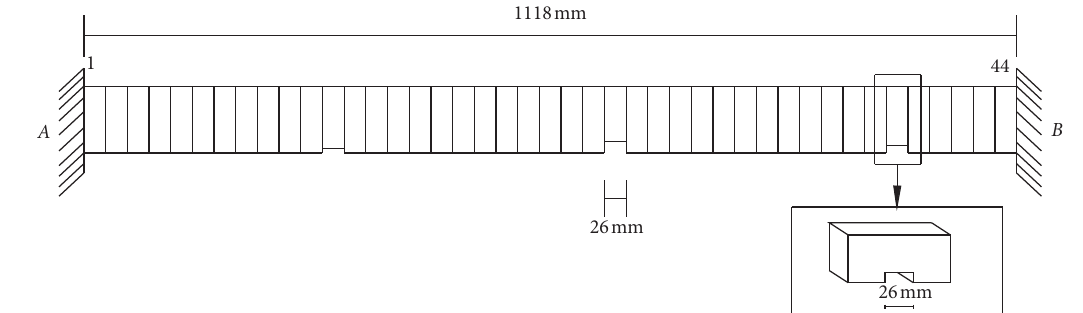
Figure 2: The fixed beam with